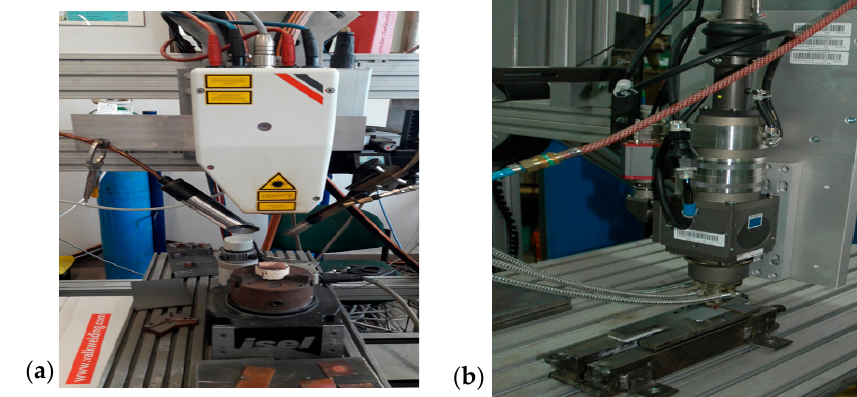
Figure 1. Lasers used in the experiment: ( a ) diode laser; ( b ) disc laser [24]. Table 1. Laser sources used.